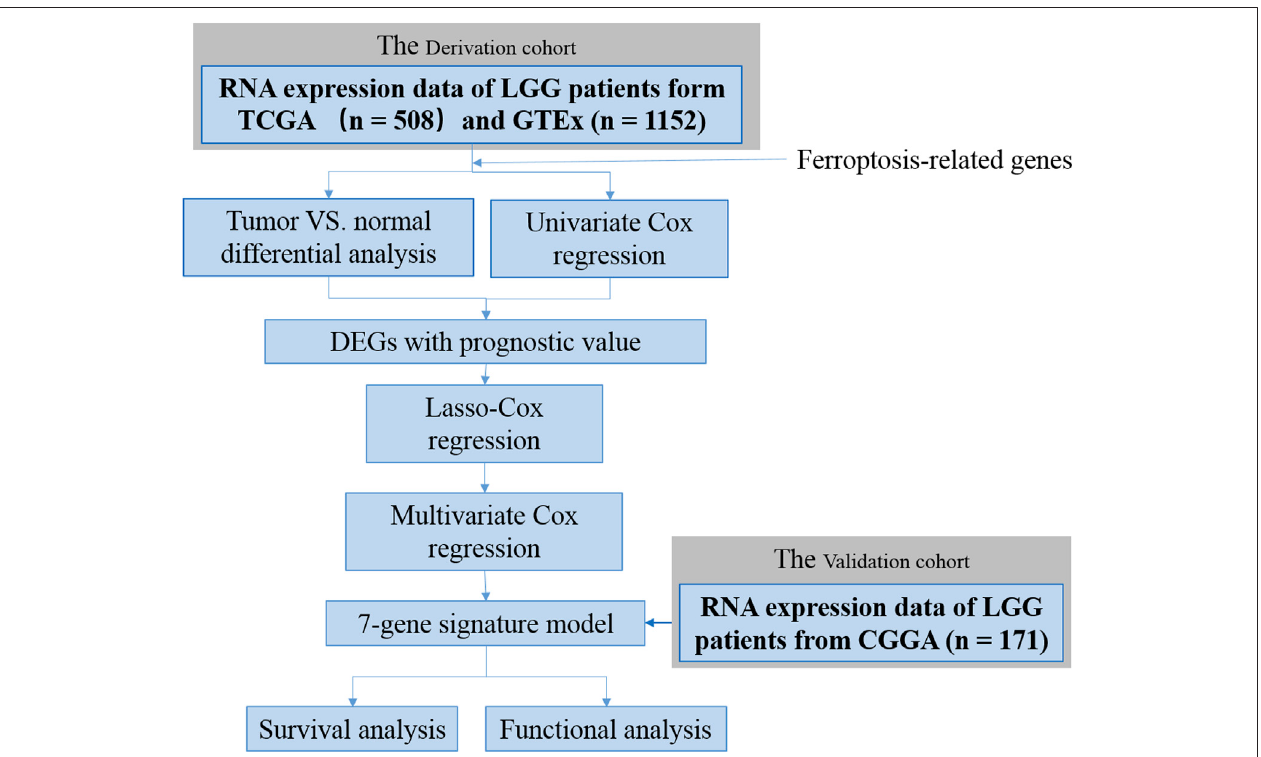
FIGURE 1 | Flow chart of data collection and